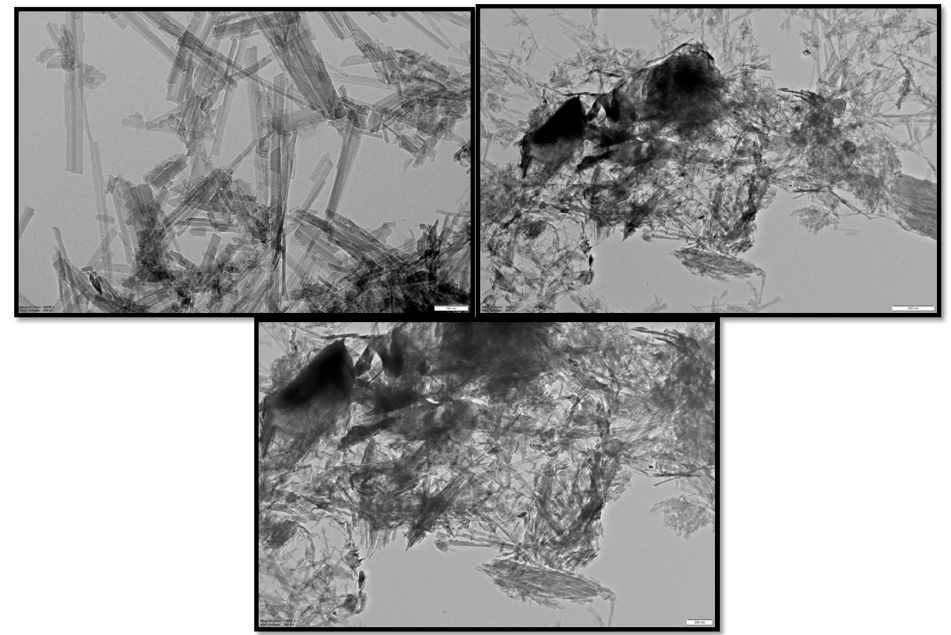
Figure 5. TEM images of composite material with di ff erent magnification (sublimed sulfur / post-treated sepiolite/PAni).